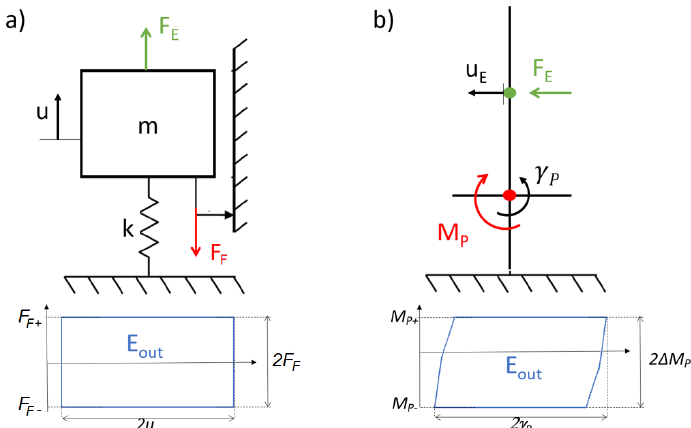
Figure 6. ( a ) Den Hartog 1 DoF oscillator; ( b ) simplified representation of a blade. The hysteresis cycles produced by friction are shown below each system.